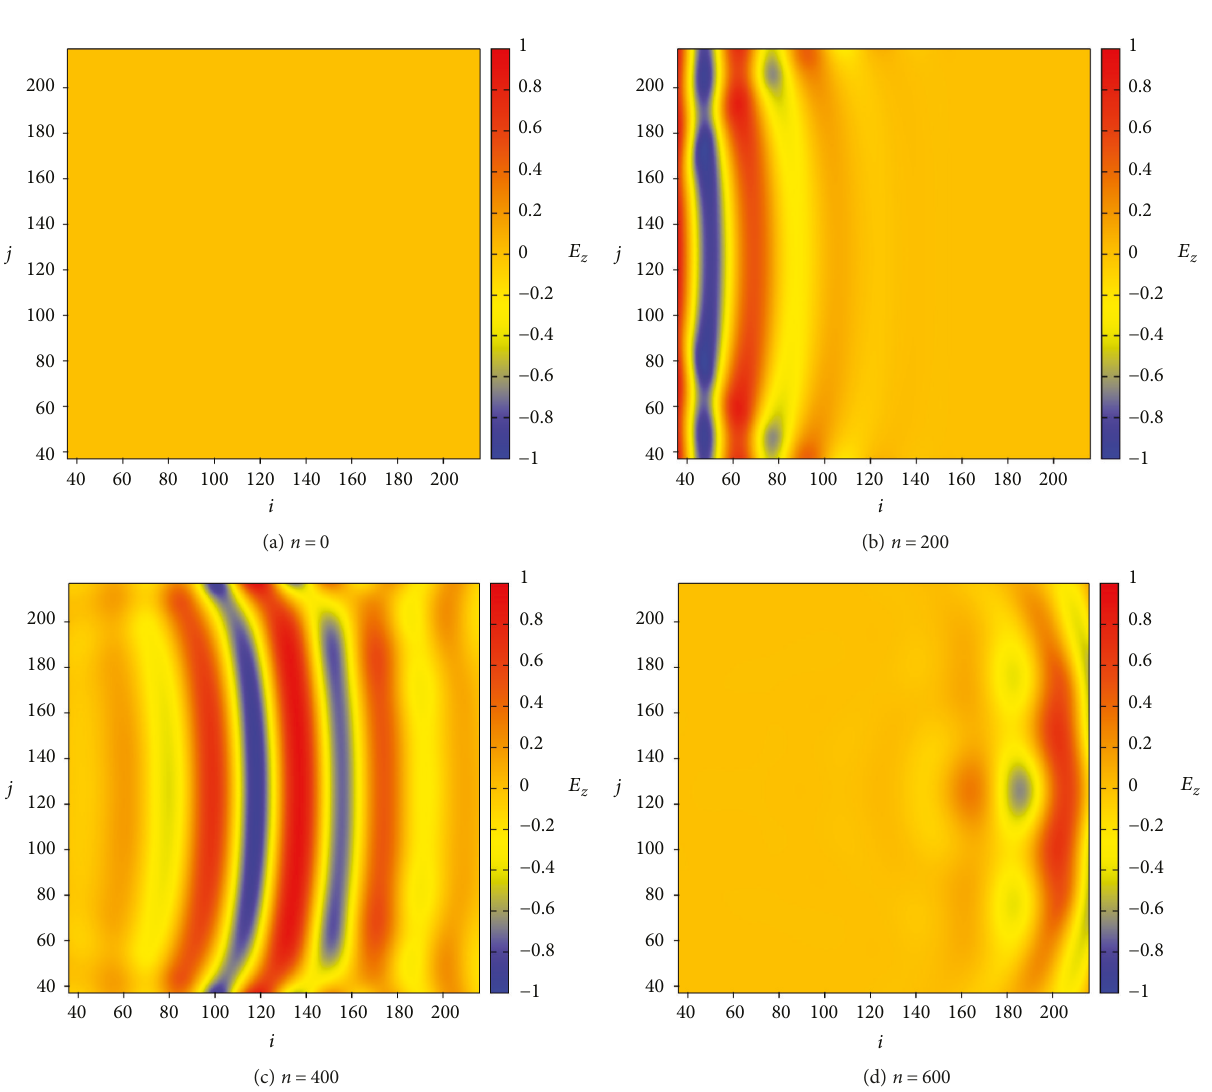
Figure 5: Time evolution of the intensity of the electric fi eld, in volts/meter, across the computational domain, for the homogeneous case where incident wave frequency is set to f =10GHz, electron density is set to n =5 × 10 17 m − 3 , and electron collision frequency is set to in ν =500 × 10 6